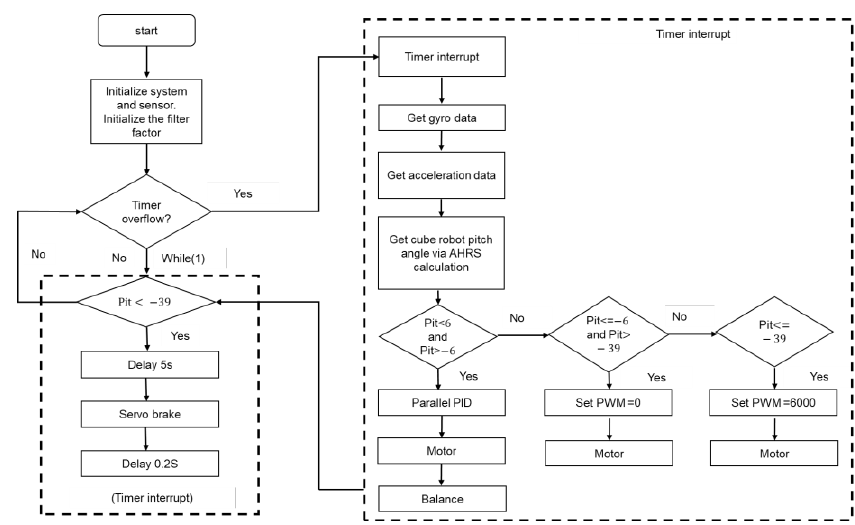
Figure 14. The flow chart of bounce and balance control.